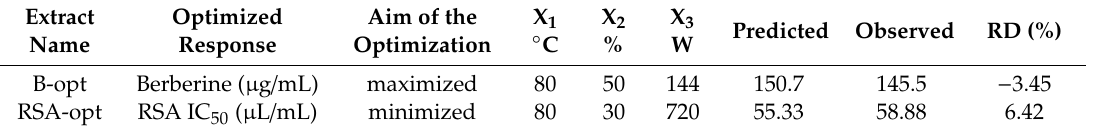
Table 5. Predicted and observed values for the optimized response variables.